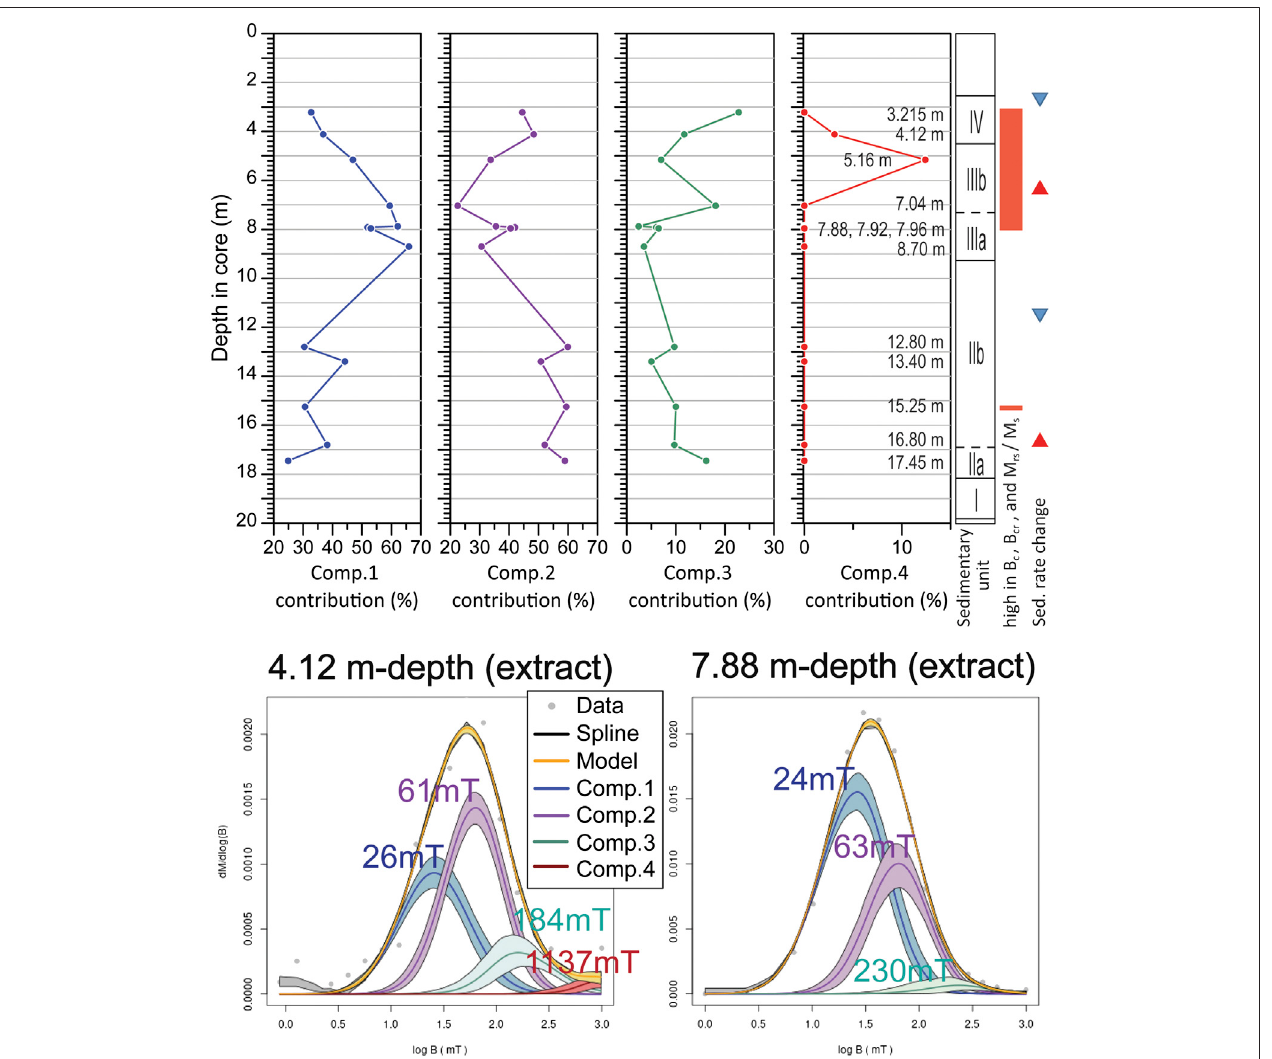
FIGURE8| TwoexamplesofIRMcomponent unmixinganalyssresultsbyusingMaxbaueretal.(2016) (lower) and relativecontributionsoftheunmixedmagnetic mineral components for samples at different depths ( upper; n (cid:1) 13). In the fi gures of the lower panel, the mean coercivity (Bh) of each unmixed component (comp.) is labeled. On the right hand of the upper panel fi gure, the division of sedimentary units (the same as in Figure 2 ), the intervals with high values in B c , B cr , and M rs /M s (the same as in Figure 4 ), and the depths above which the sedimentation rate changes signi fi cantly (the same as identi fi ed in Figure 3 ; the triangles are the same as in Figure 4 ) are supplementarily